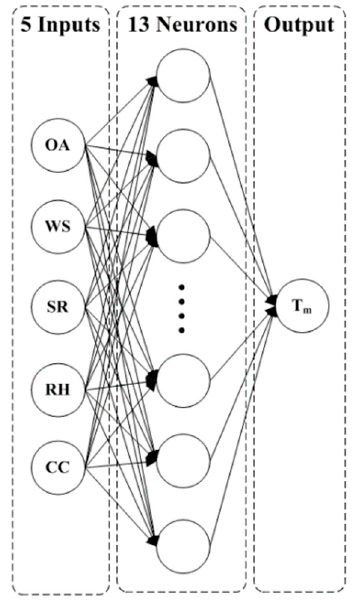
Figure 4. Diagram of the initial ANN model.